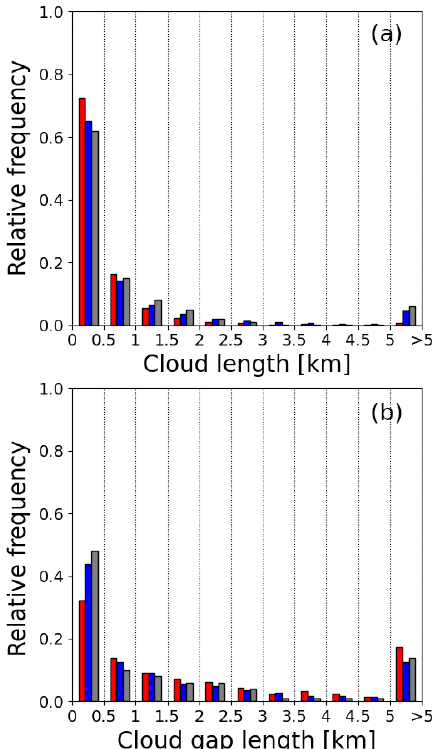
Figure 7. Histograms of detected cloud lengths (a) and cloud gap lengths (b) . Red bars illustrate the distribution of marine low cloud (gap) lengths located below Saharan dust layers. Blue bars represent the distribution derived from measurements in the dust-free trades during NARVAL-II. Grey bars show the derived distribution in the dust-free winter season during